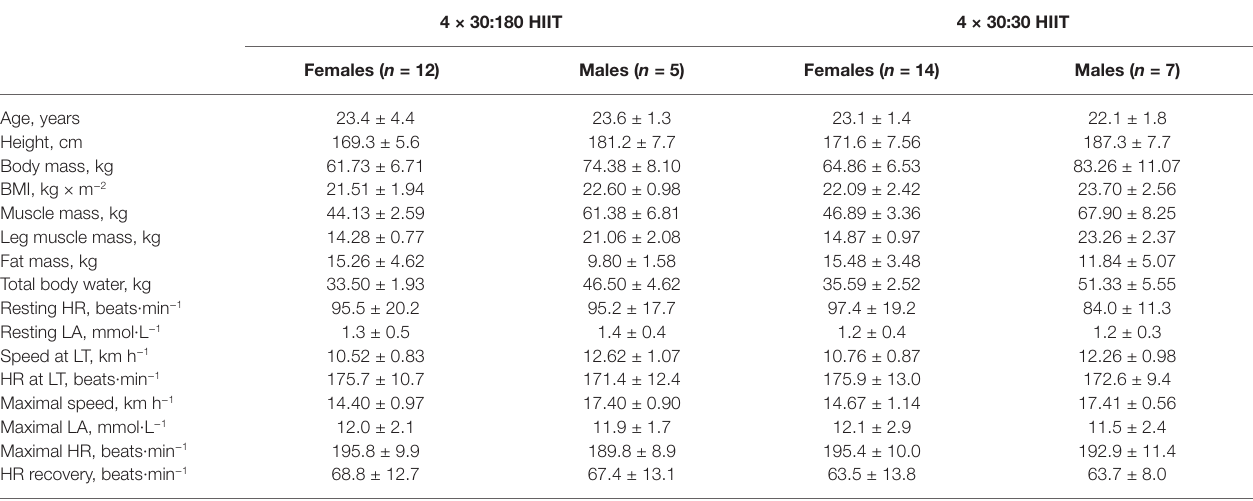
TABLE 2 | Participants’ characteristics at baseline.